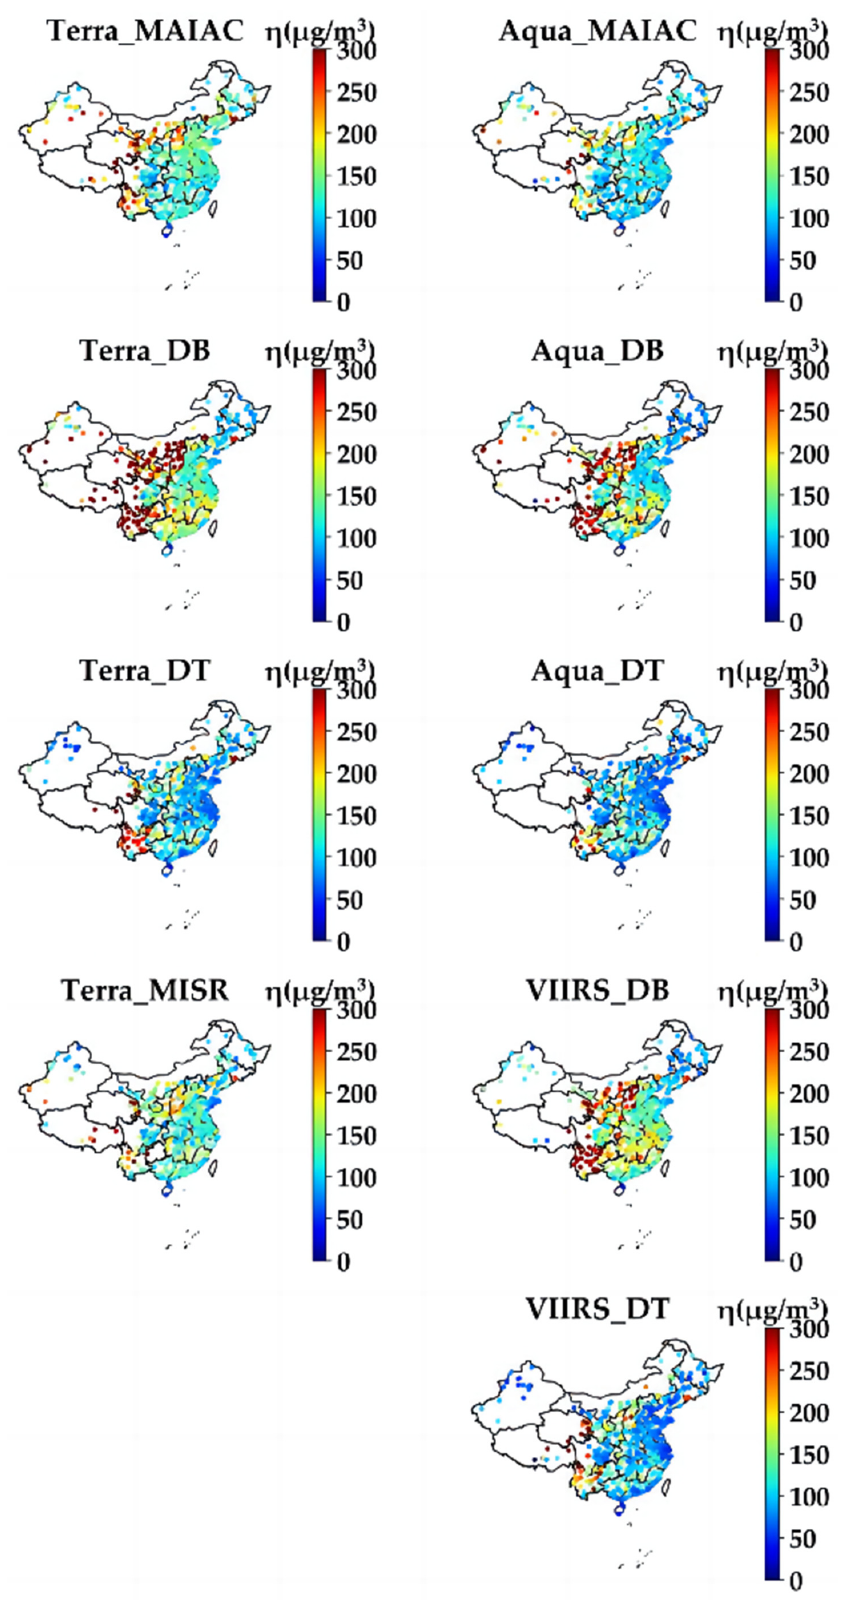
Figure 3. The spatial distribution of the PM 2.5 /satellite AOD ratio ( η ). Terra_MAIAC, Aqua_MAIAC, Terra_DB, Aqua_DB, Terra_DT, Aqua_DT, Terra_MISR, VIIRS_DB, and VIIRS_DT represent the same implication as in Figure